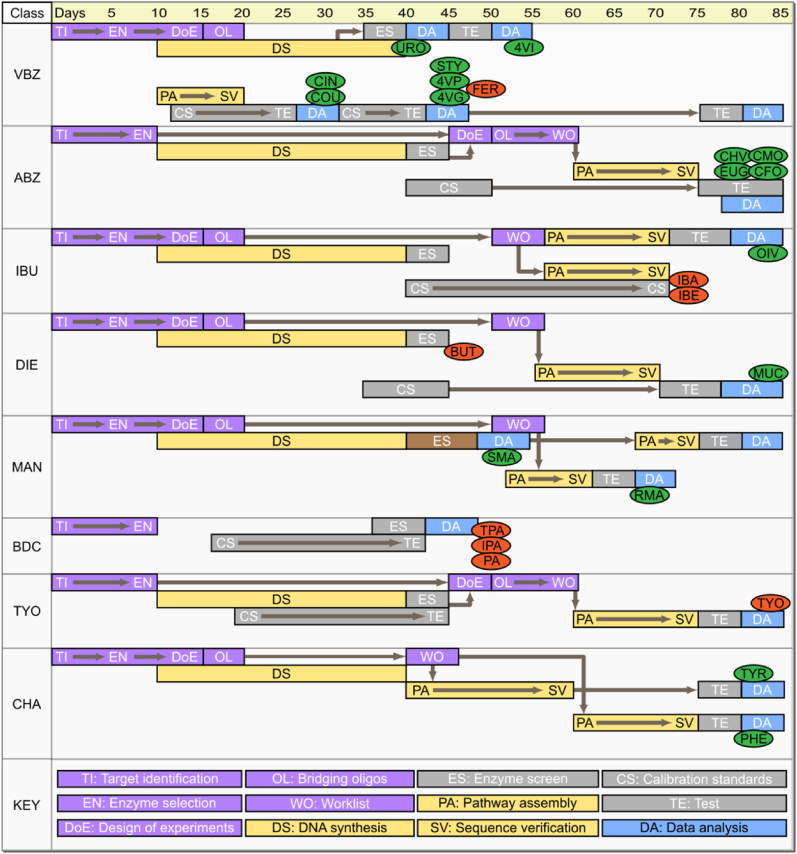
Gantt chart representing key milestones and their dependencies within the biomanufacturing pipeline. Steps within the DBTL pipeline are color-coded: Design (purple); Build (yellow); Test (gray); Learn (blue). Abbreviations within ovals represent target compounds and appear at their delivery points (3 letter codes are listed in Table 1). Targets successfully produced in vivo are green, red targets were not produced. Compound class abbreviations are: VBZ, vinylbenzene and phenylacrylic acid targets; ABZ, allylbenzene and monolignol targets; IBU, isobutyl compound targets; DIE, butadiene and muconate; MAN, mandelate targets; BDC, benzene dicarboxylate targets; TYO, tyrosol; and CHA, chassis metabolites. BDC targets are: terephthalic acid (TPA), isophthalic acid (IPA) and phthalic acid (PA). (For interpretation of the references to color in this figure legend, the reader is referred to the Web version of this article.)